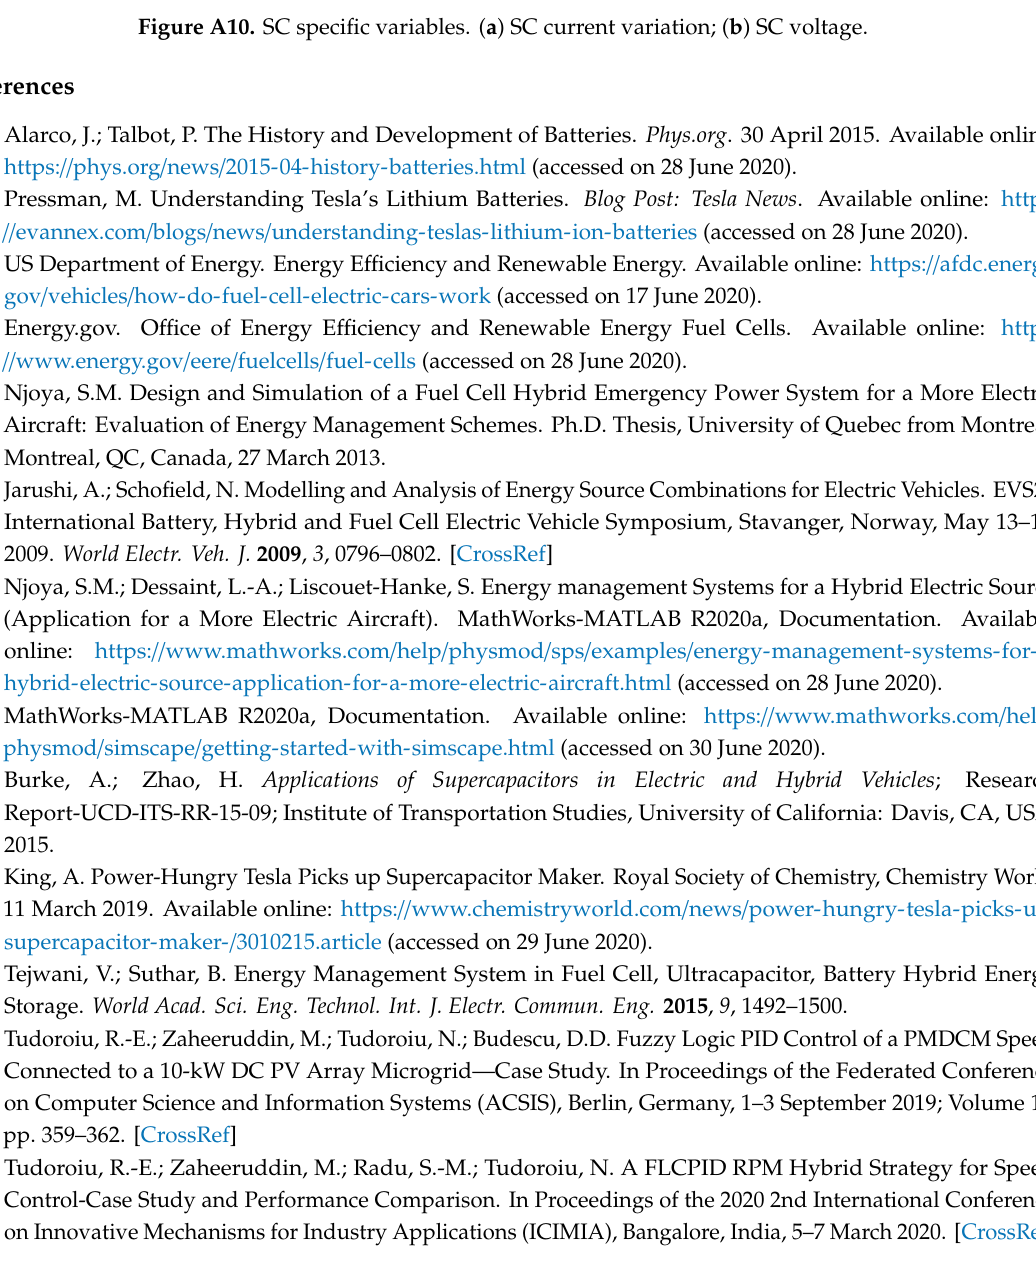
Figure A10. SC specific variables. ( a ) SC current variation; ( b ) SC voltage.